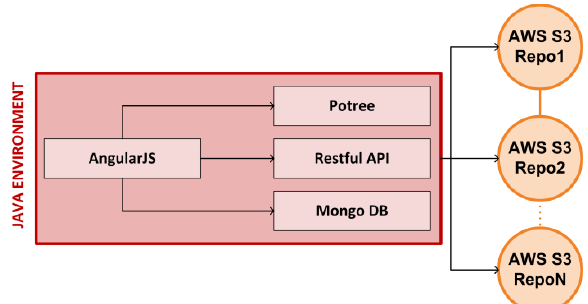
Figure 4. The infrastructure of the developed web